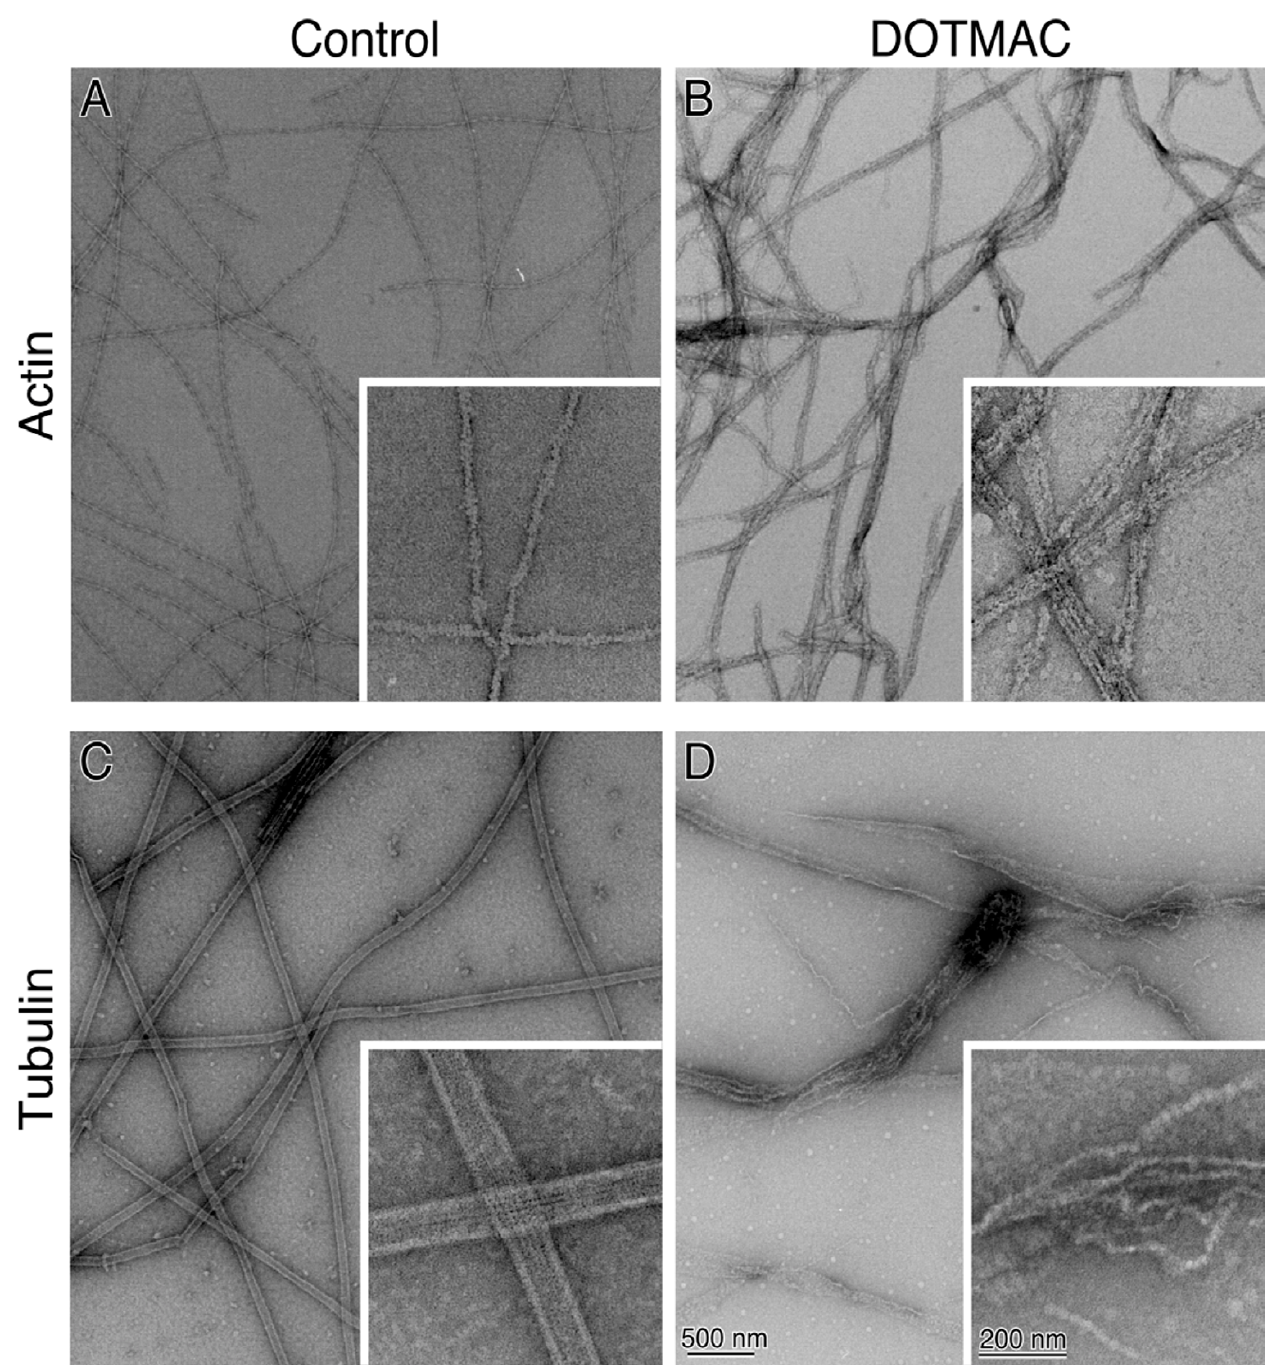
Figure 8 Negative staining electron micrographs of rabbit skeletal muscle F-actin (A and B) and bovine microtubules (C and D) in the absence (A and C) and presence (B and D) of DOTMAC. Note that DOTMAC induces bundling of actin filaments and microtubules. Bars: (overviews) 500 nm; (inserts) 200